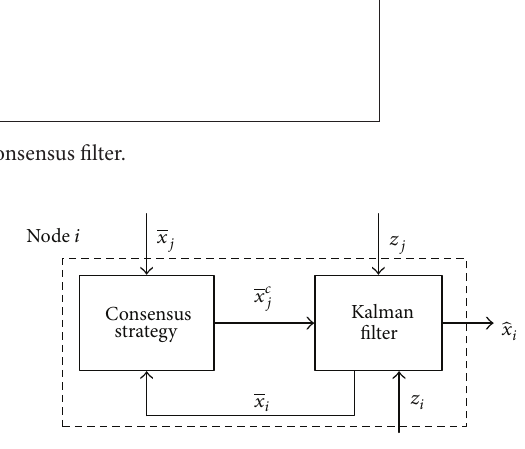
Figure 1: The algorithm structure of node 𝑖 in the